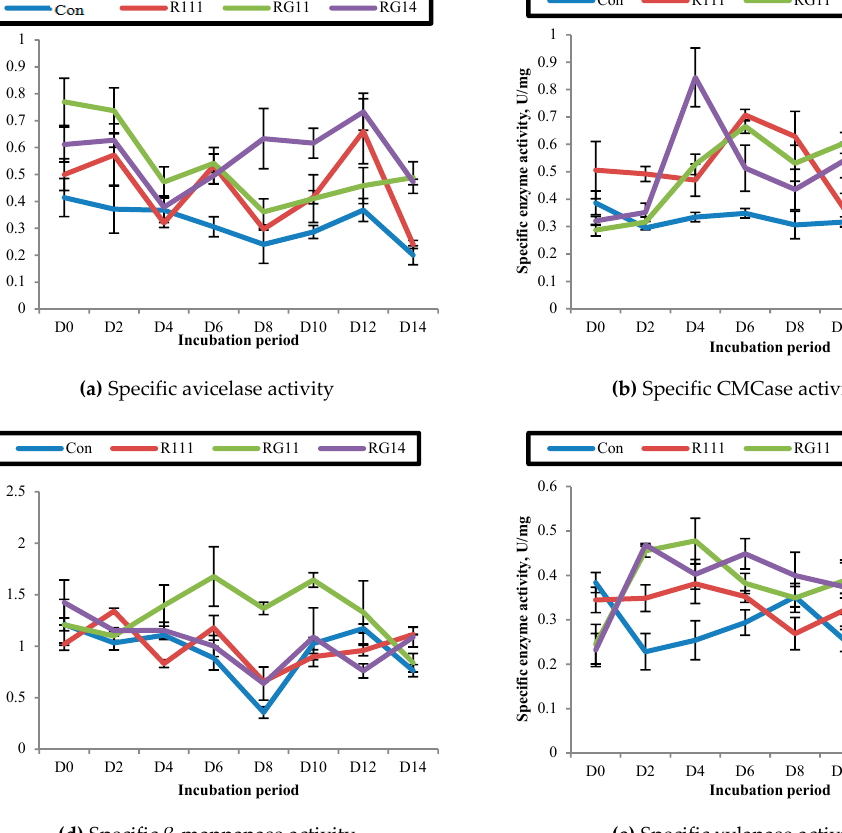
Figure 4. Cellulolytic, hemicellulolytic, and proteolytic enzyme activities of palm kernel cake extract treated with Lactobacillus plantarum R111, RG11, and RG14 via solid state fermentation for 14 days. ( a ) Specific avicelase activity; ( b ) Specific carboxymethylcellulase activity (CMCase); ( c ) Specific β -glucosidase activity; ( d ) Specific β -mannanase activity; ( e ) Specific xylanase activity; ( f ) Specific endoprotease activity. Notes: Con, unfermented palm kernel cake; R111, L. plantarum RI11; RG11, L. plantarum RG11 and RG14, L. plantarum RG14. Error bar: standard error of mean (SEM), n = 3.